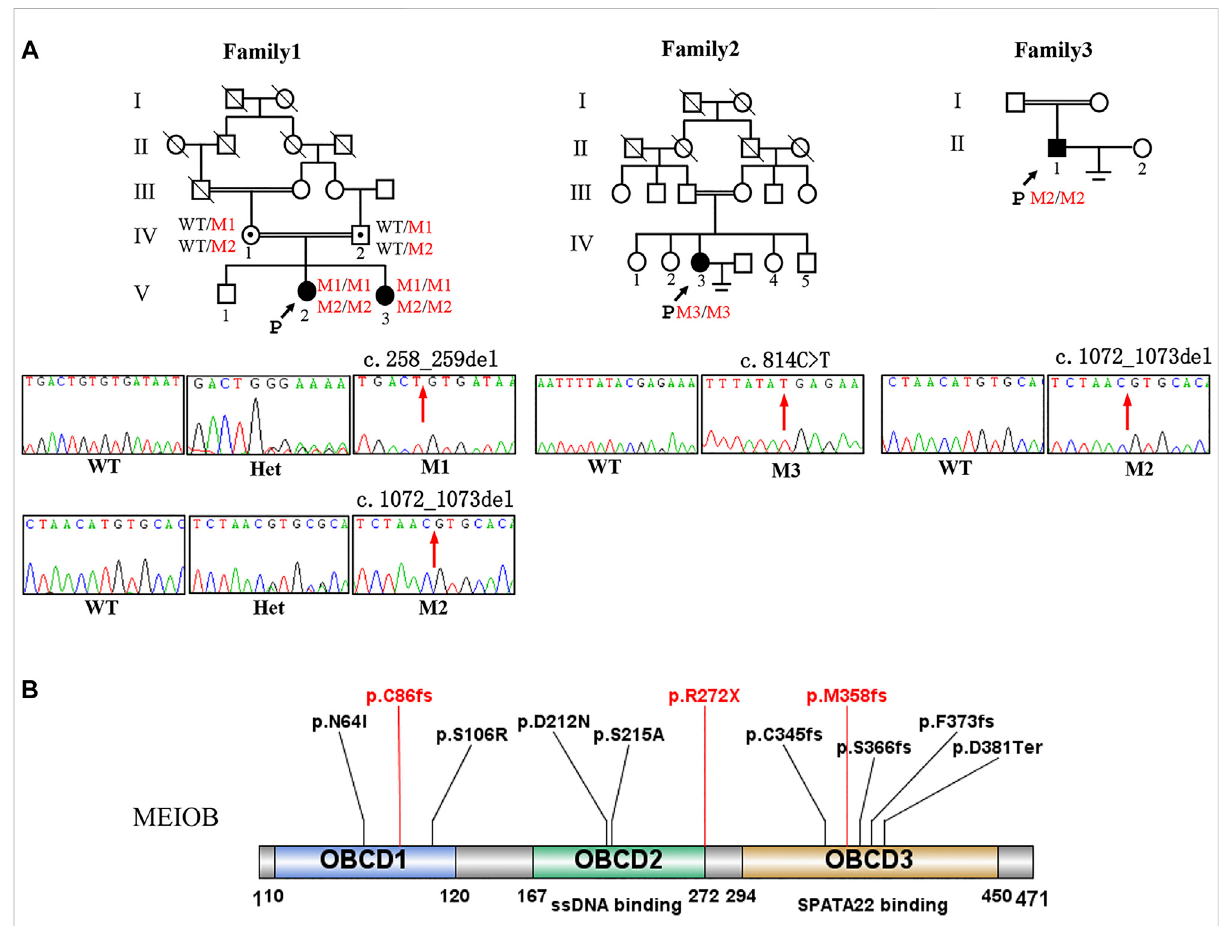
FIGURE 1 Pedigree of three consanguineous Han Chinese family with infertility-related MEIOB variants. (A) The black arrow points to the proband. Open symbols indicate the unaffected members. Heterozygous carriers are indicated with a dot in the middle of the symbol. Filled symbols indicate the affected members with POI or NOA. In family Ⅰ , two cousins ( Ⅳ -1 and Ⅳ -2) in generation 4 married to each other with two affected individuals (V- 2 and V-3 with POI). Sanger sequencing of the c.258_259del and c.1072_1073del (pointed by red arrows) mutation of MEIOB in this family. (B) The MEIOB protein consists of 471 amino acids, including three OB- domains. Three variants discovered in thisstudy are shown in red font, whereas previously reported variants are displayed in black